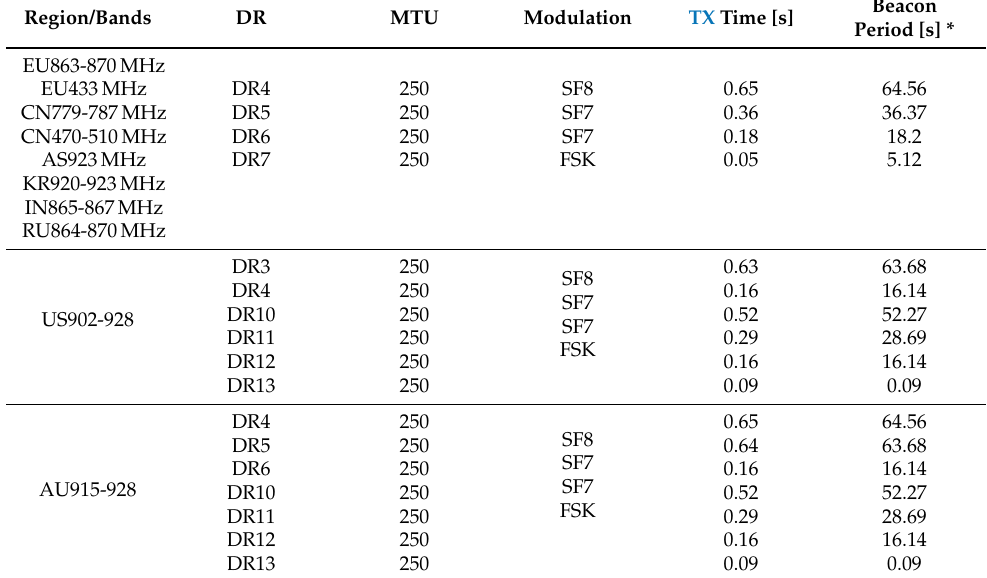
Table 3. Bootstrapping information transmission time and their minimal periodicity for different regions and channel